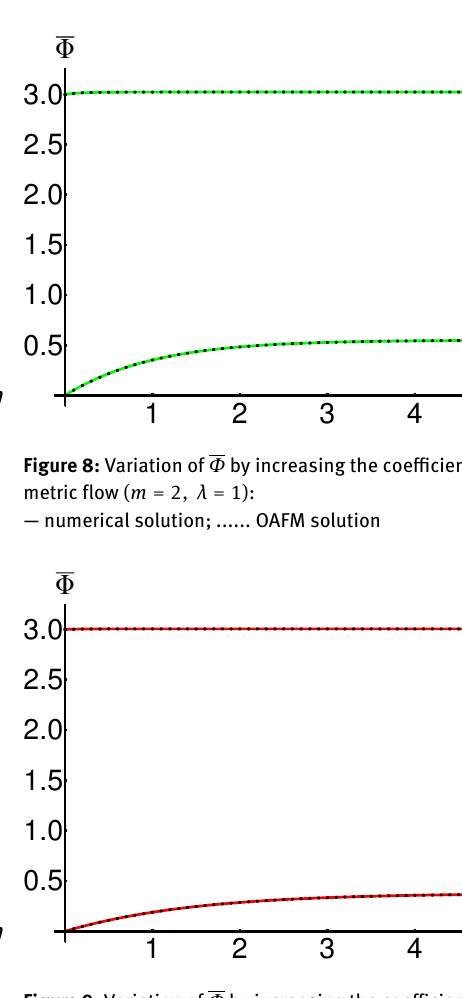
Figure 6: Variation of Φ by increasing the coeflcient α for planar flow ( m = 1, λ = 5) :